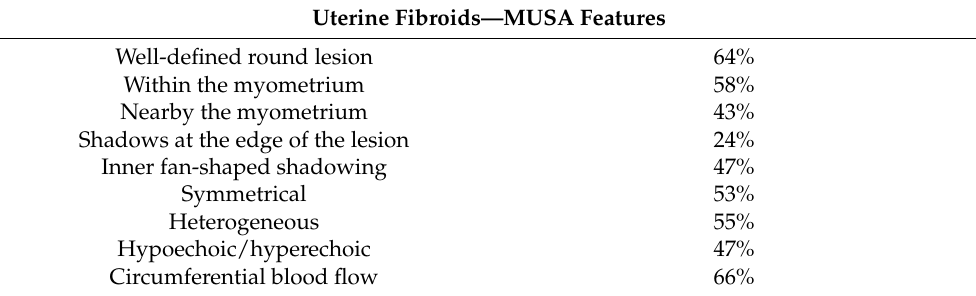
Table 1. Prevalence of MUSA features among histologically confirmed uterine fibroids, as identified upon TVUS.